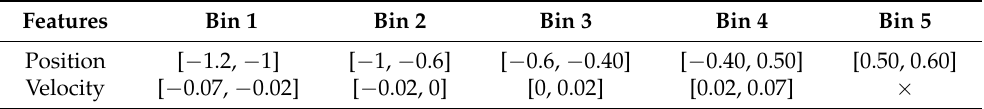
Table A4. Discretized values for each feature in the Mountaincar environment: these intervals are obtained using the K-means clustering method with K = 5 for the position and K = 4 for the velocity. For this reasons, we used the symbol × to represent the absence of the fifth bin.